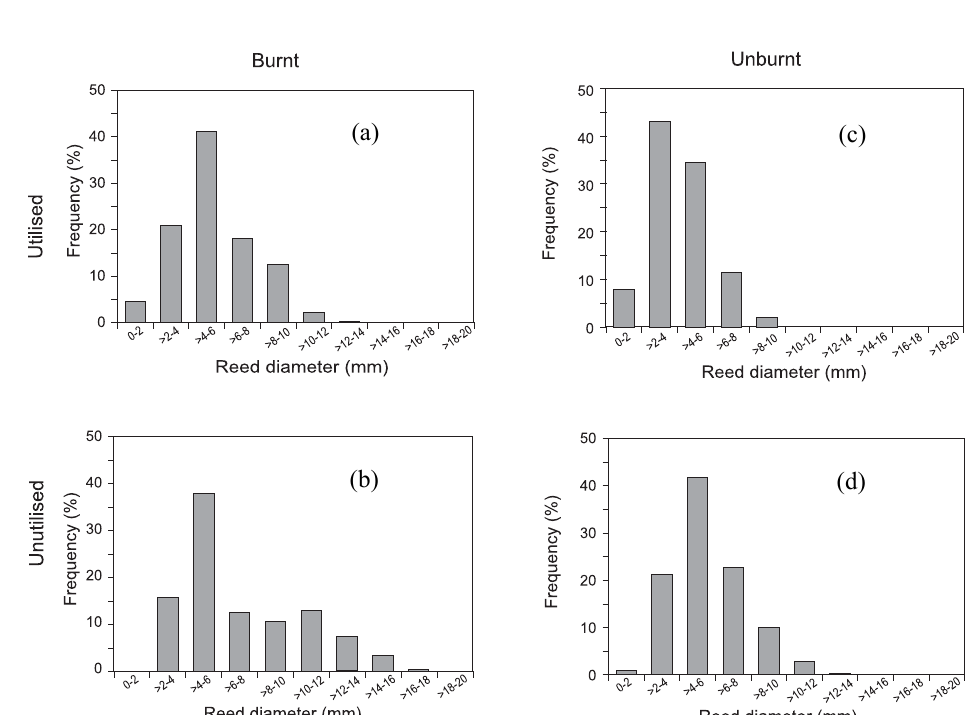
Fig. 5. Frequency distribution of different diameter size classes under different utilisation regimes in the Muzi Swamp, Tembe Elephant Park as determined by harvesting trials in 2000. (a) burnt, utilised area; (b) burnt, unutilised area; (c) unburnt, utilised area; and (d) unburnt, unutilised